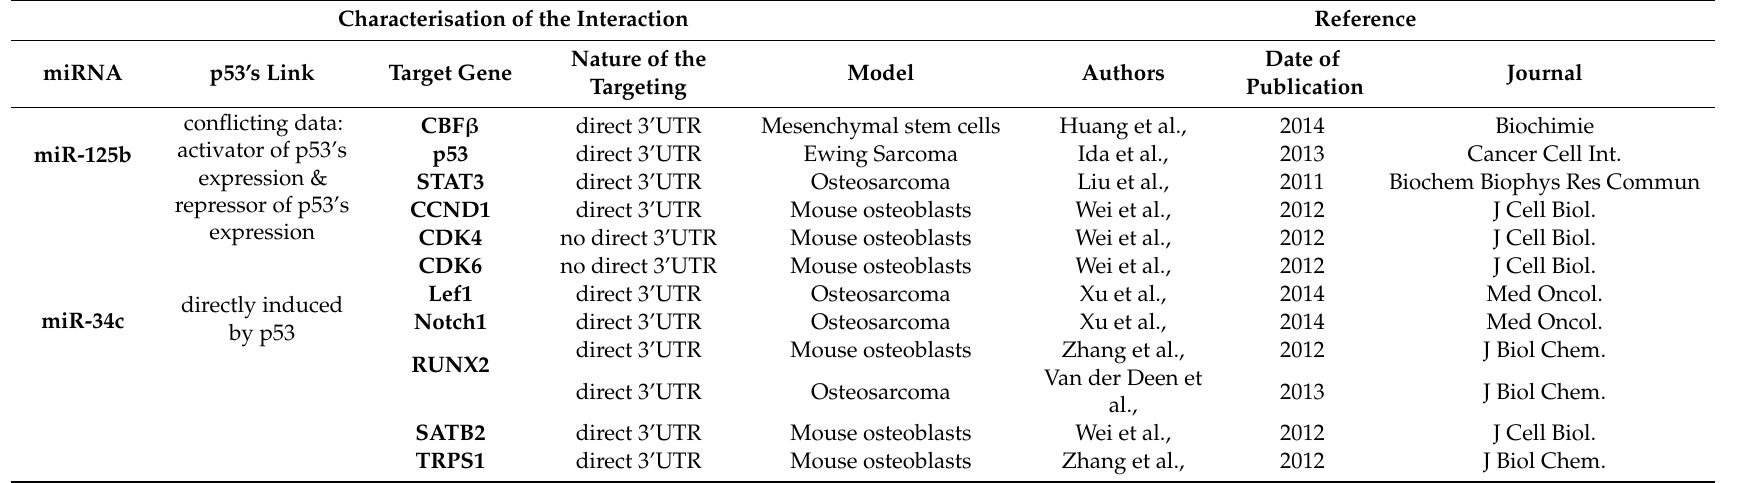
Table 1. p53-related miRNAs and the nature of the interaction with their target genes in bone development and